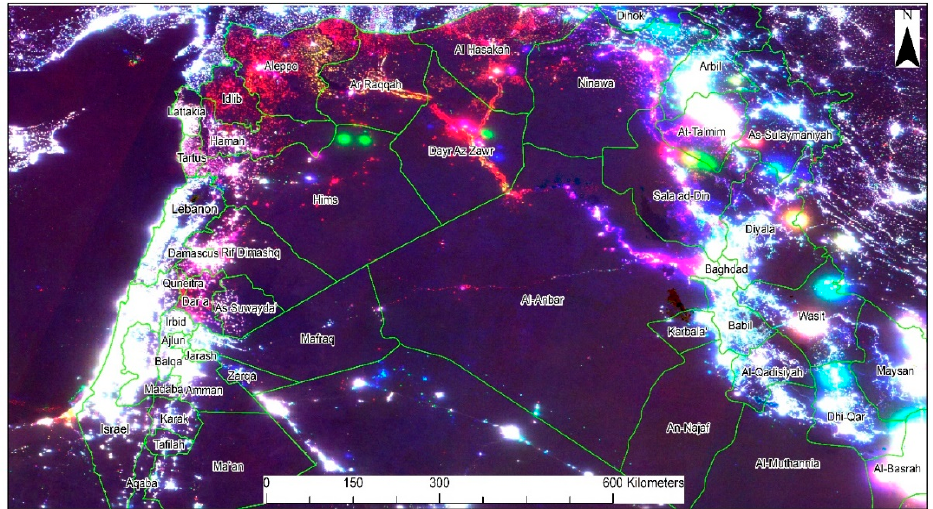
Figure 7. False-color composite (FCC) of Visible Infrared Imaging Radiometer Suite (VIIRS) night- time data acquired in October 2012 (red band), October 2015 (green band), and October 2018 (blue band) in Arabian countries.